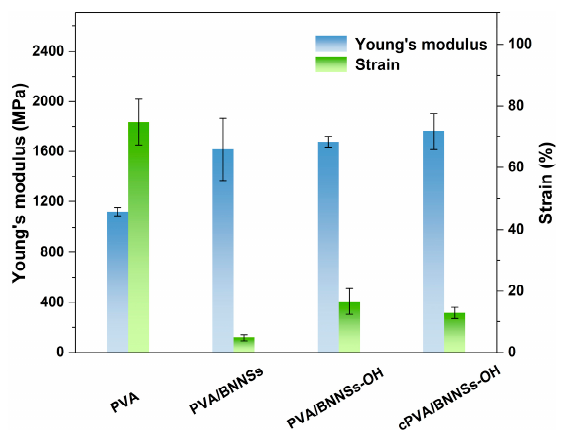
Figure 7. Young’s modulus and strain of PVA, PVA/BNNSs, PVA/BNNSs-OH, and cPVA/BNNSs- OH fi lms.